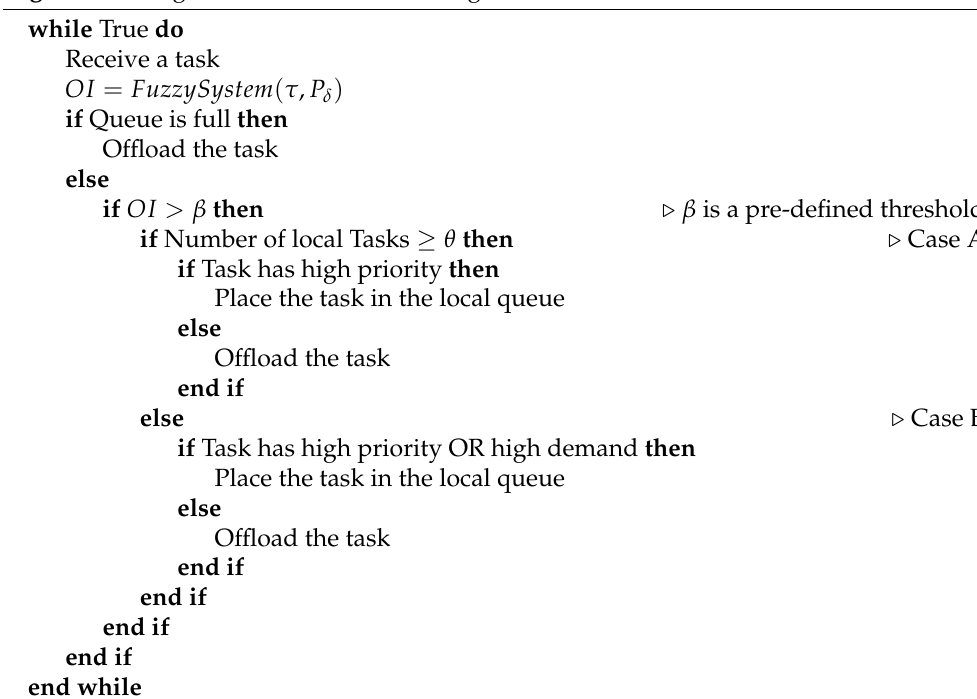
Algorithm 1 Algorithm for Task Offloading based on